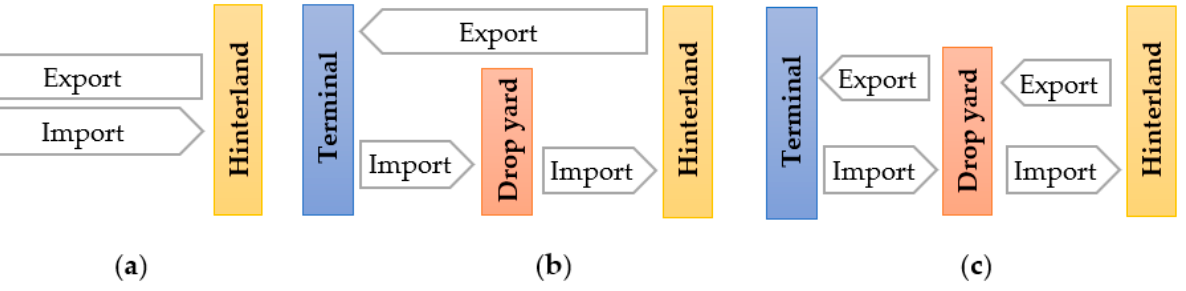
Figure 2. Drayage practice: ( a ) traditional drayage process; ( b ) drayage with drop yard used for imports; ( c ) drayage with drop yard used for both exports and